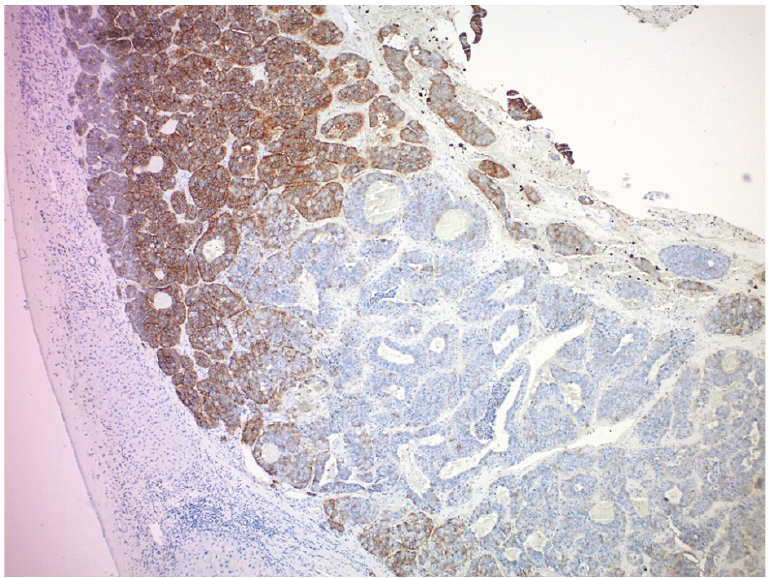
Figure 4. A representative section of liver metastasis from a small intestinal neuroendocrine tumor showing heterogeneous SSTR2 expression.